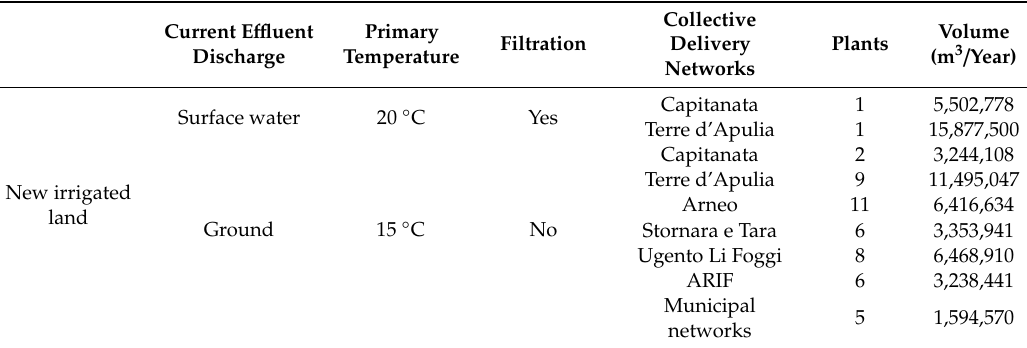
Table 7. Reclaimed urban wastewater readily available for irrigation in Puglia (2015).